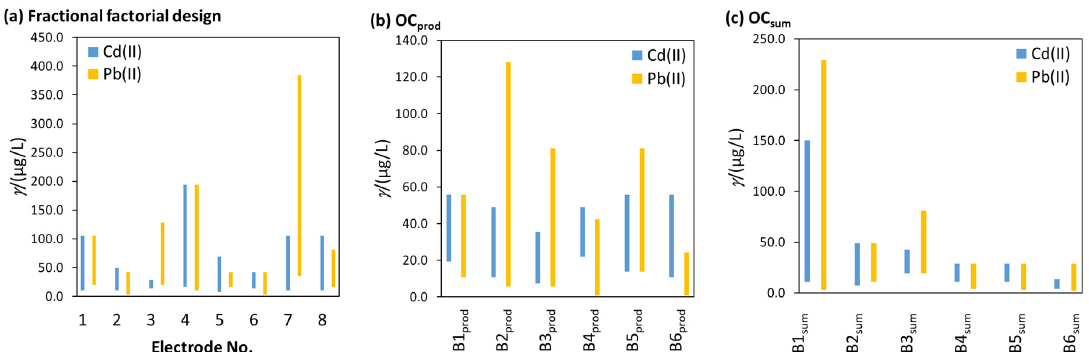
Figure 2. Linear concentration ranges for Cd(II) and Pb(II) determined during the course of ( a ) fractional factorial design testing, ( b ) simplex optimization, where the optimization criteria was OC prod , and ( c ) simplex optimization, where the optimization criteria was OC sum .